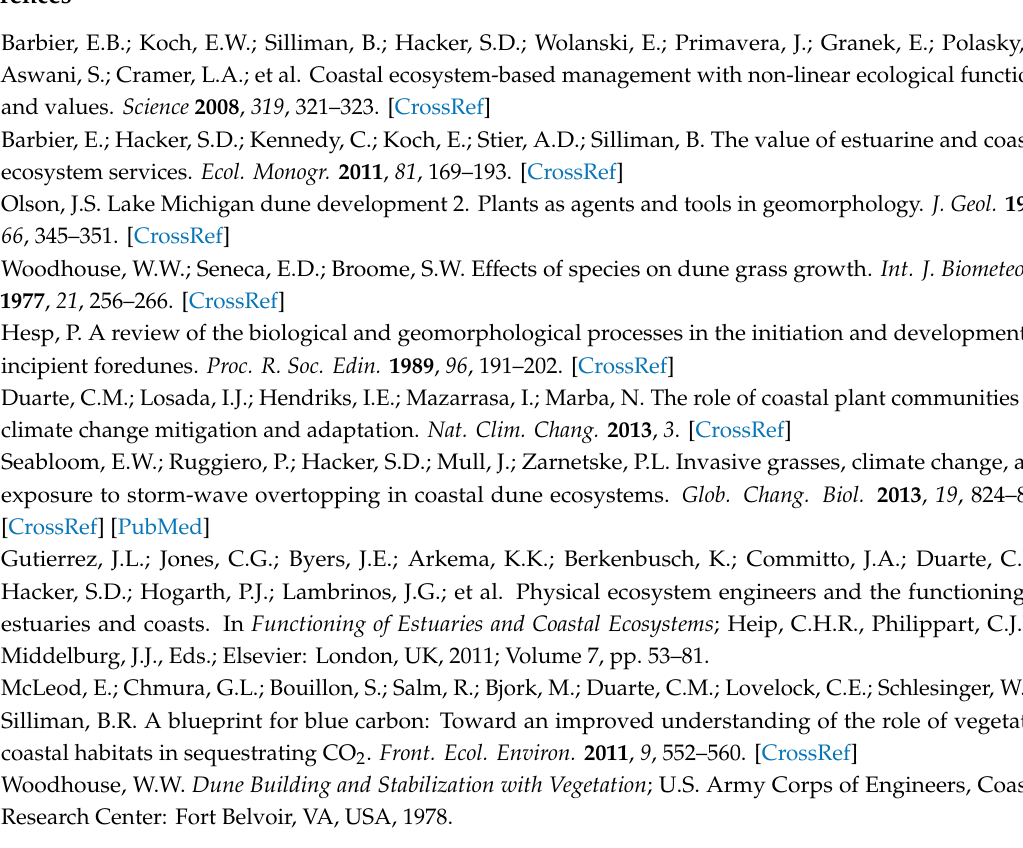
Table S1: Transect locations, north to south, used to survey the distribution and abundance of vegetation along foredunes of the Outer Banks islands from False Cape, Virginia, to Bogue Banks, North Carolina, USA (see Figure 2), Table S2: List of the 53 plant species found in foredune surveys of the Outer Banks islands from False Cape, Virginia, to Bogue Banks, North Carolina, USA, Table S3: One-way ANOVAs and associated Tukey’s post hoc tests ( p ≤ 0.05) for the abundance of (A) plant functional groups (grasses, forbs, vines, and shrubs) on di ff erent islands (abbreviations in Table S1), (B) dune grass species (abbreviations in Table S2) on di ff erent islands, and (C) dune grass species across the dune profile (toe / face, crest, and heel / back) in foredunes of the Outer Banks islands from Virginia to North Carolina, USA, Table S4: Mean ( ± 95% CI) growth form and morphological di ff erences of the four dominant dune grass species (abbreviations in Table S2) in foredunes of the Outer Banks islands,